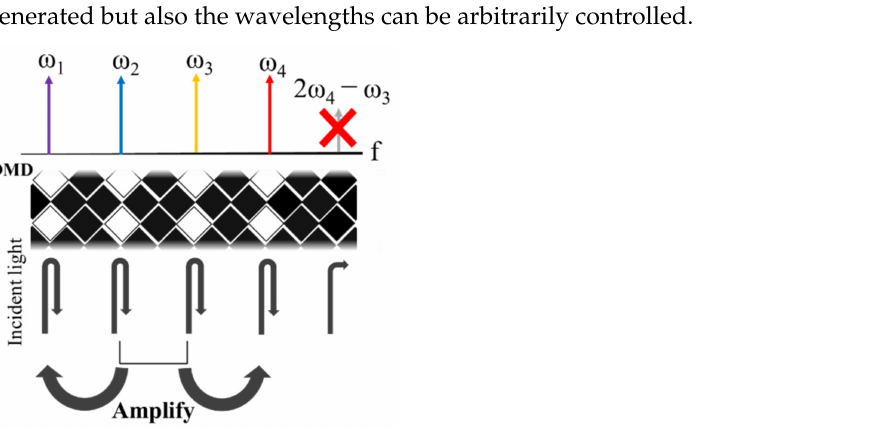
Figure 2. Four-wave mixing is generated by reflecting equally spaced wavelengths. Unwanted wavelength components can be blocked by the